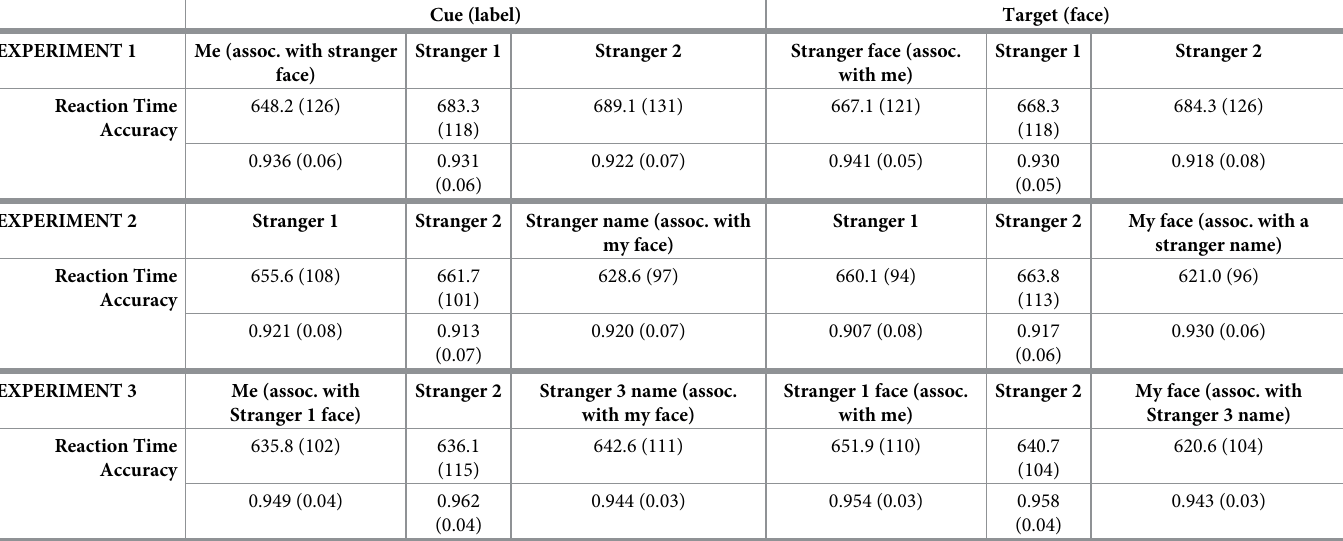
Table 1. Mean reaction times and accuracy (standard deviation in brackets) for all three experiments. Cue